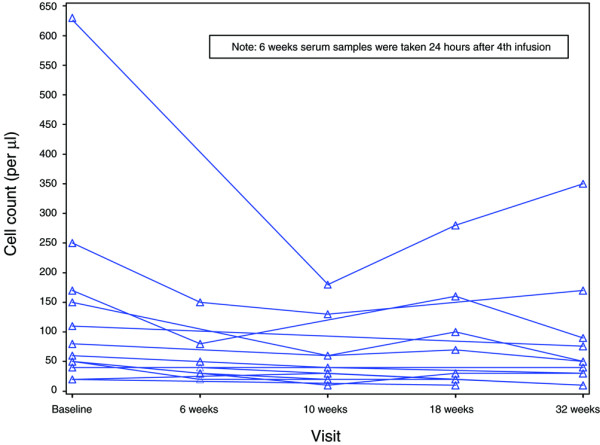
Follow-up of peripheral B cell levels during the study among individual study patients.